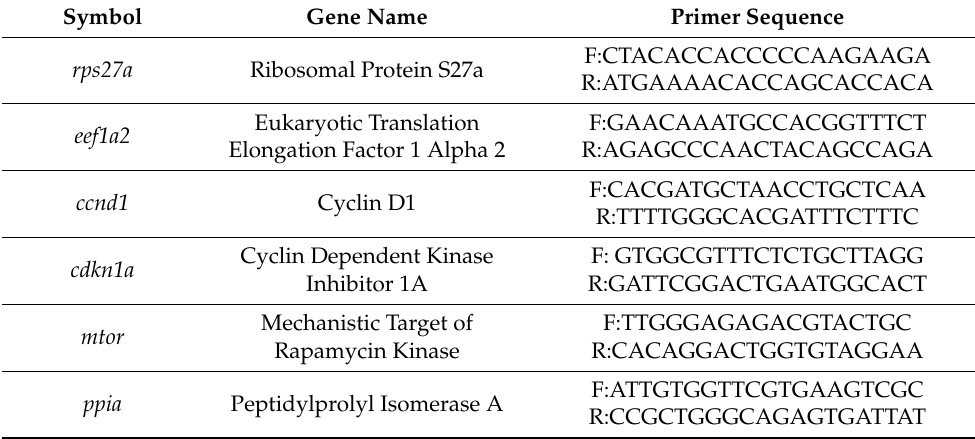
Table 1. Primers that were used for the amplification of rps27a , eef1a2 , ccnd1 , cdkn1a , mtor , and ppia mRNAs by RT-qPCR. F, forward; R, reverse. The genes are as follows: rps27a (ribosomal protein s27a), eef1a2 (eukaryotic translation elongation factor 1 alpha 2), ccnd1 (cyclin D1), mtor (mammalian target of rapamycin), cdkn1a (cyclin-dependent kinase inhibitor 1A), and ppia (peptidylprolyl isomerase